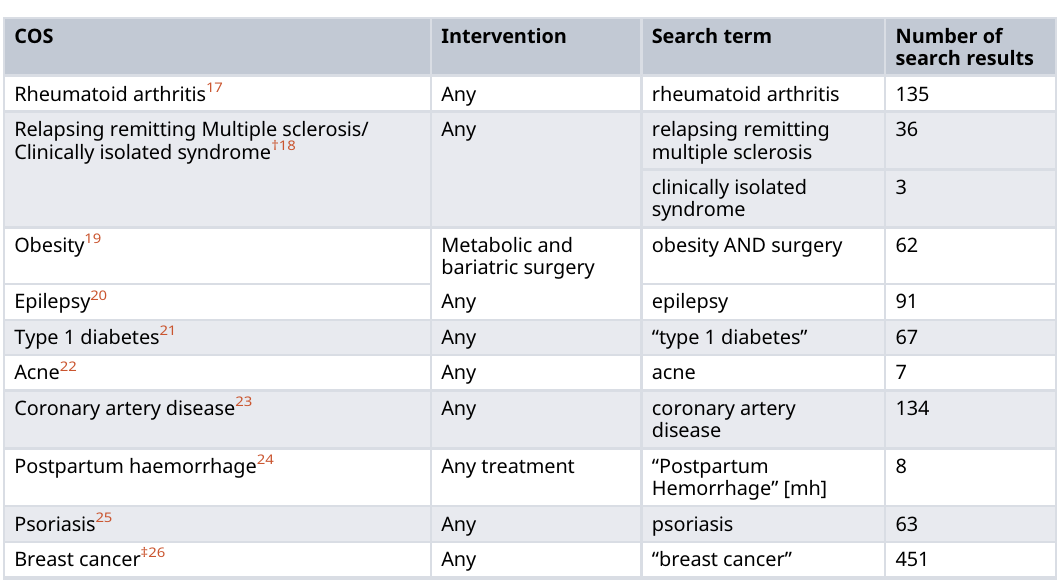
Table 1. Summary of search terms and number of search results.